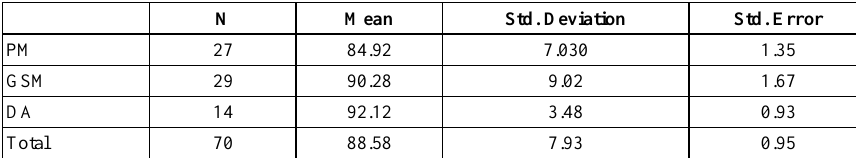
Table 3. Descriptive statistics of exam